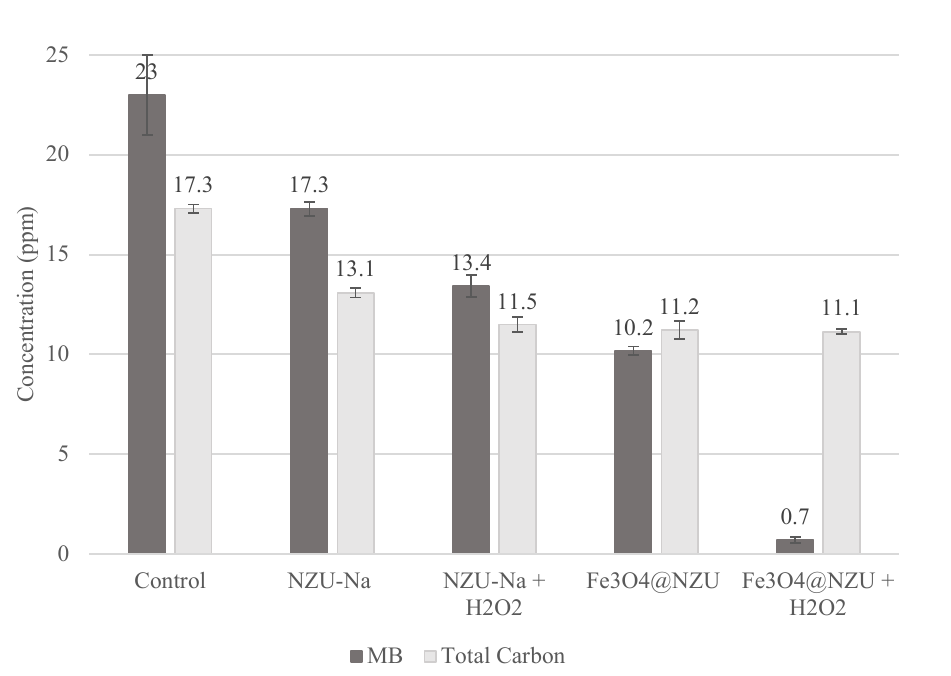
Figure 10. Discoloration of MB solutions and and TC removal by the modified zeolites (H 2 O 2 concentration: 42.4 mM).